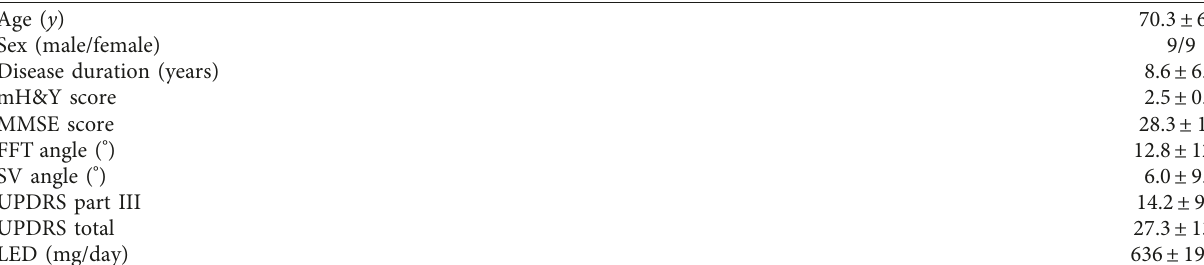
Table 1: Characteristics of the study patients ( n �